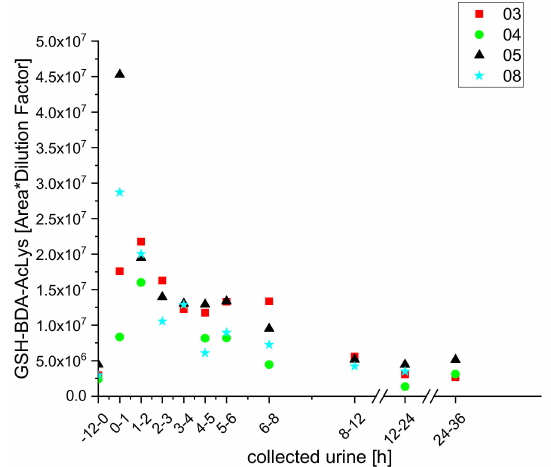
Figure 7. Excretion kinetics of GSH-BDA-AcLys: UPLC-qToF-MS / MS measurements of contents in samples of urine from participants three, four, five, and eight at indicated times after co ff ee consumption